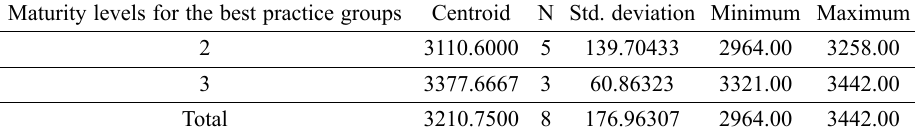
Table 4. Centroids by maturity levels for the best practice groups Maturity levels for the best practice